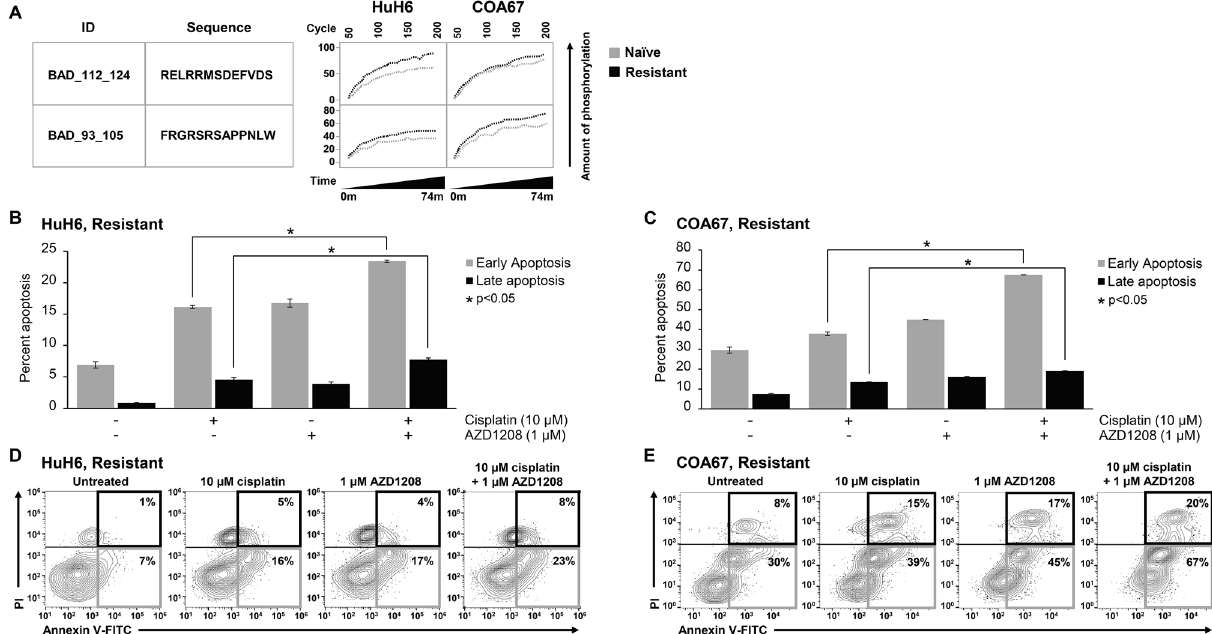
Figure 4. PIM3 inhibition with AZD1208 promotes cisplatin-induced apoptosis. ( A ) Kinetic phosphorylation curves for peptides identified as potential PIM3 targets were overlaid for both cisplatin-naïve and cisplatin- resistant tumors. Phosphorylation of the pro-apoptotic protein BAD at phosphorylation sites that inhibit apoptosis was increased in resistant compared to naïve tumors in both HuH6 and COA67 xenografts, indicating decreased apoptosis in resistant cells. ( B – E ) Cisplatin-induced apoptosis was assessed by flow cytometric analysis of Annexin V/PI dual staining. ( B ) HuH6 and ( C ) COA67 cisplatin-resistant cells with or without treatment with 1 µM AZD1208 and/or 10 µM cisplatin for 72 h (for HuH6) and 24 h (for COA67) were stained and analyzed. Values expressed as mean percentage ± SEM. PIM inhibition with AZD1208 significantly promoted early (Annexin V + PI- cells, lower right quadrant ( D , E )) as well as late (Annexin V + PI + cells, upper right quadrant ( D , E )) apoptosis in cisplatin-resistant cells, indicating that the addition of PIM inhibition enhanced cisplatin-mediated apoptosis. Representative contour plots shown for both ( D ) HuH6 and ( E ) COA67 cisplatin-resistant cells along with appropriate staining controls (top